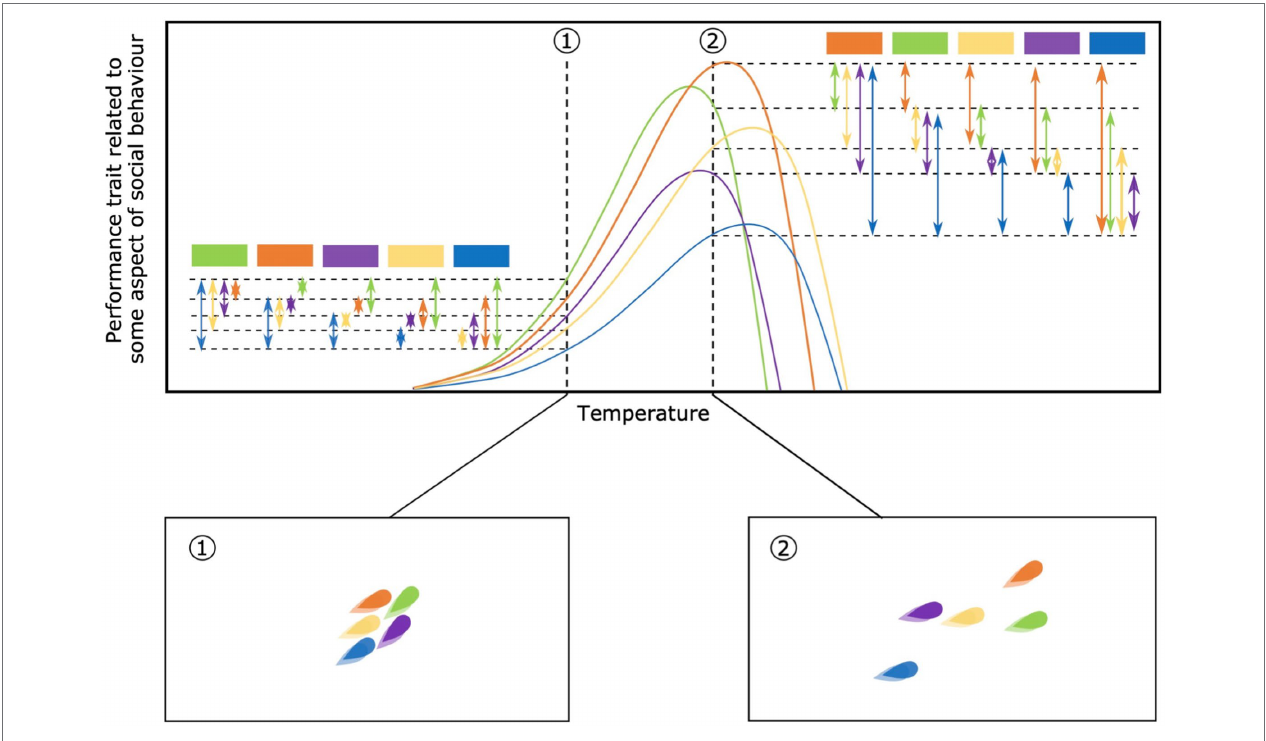
FIGURE 3 | Change in among-individual variation along the environmental gradient. On the top panel the among-individual variation is highlighted at 2 different temperatures, when individual performance curves converge (temperature 1) or diverge (temperature 2). Each color refers to an individual within the same social group. Square boxes represent individuals used as a reference to show the amount of variation. Arrows show the amount of variation between individuals. In the bottom panels is shown an example of the consequences of among-individual variation in performance curves on social groups. Wider variation could lead to less cohesion, i.e., higher distances among individuals within the same group, here shown at temperature 2 compared to temperature